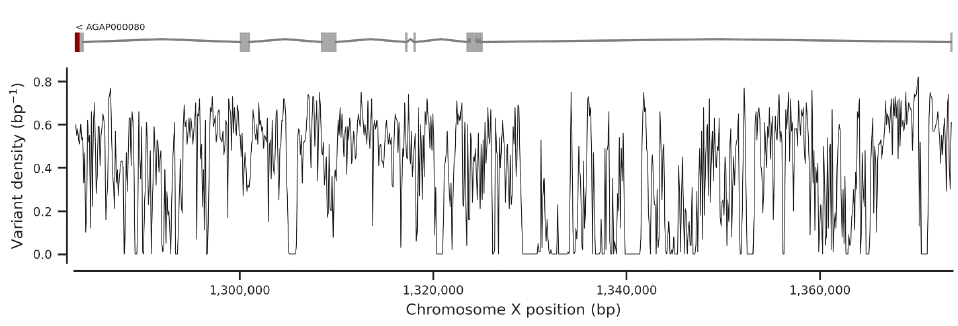
Figure A1. Variant density (bp −1 ) in the genomic region of the Fruitless gene; upper figure is the genomic region of the Fruitless gene (rectangles correspond to the exonic regions, simple lines are the intronic regions, and dark-red end is the 3 prime UTR); lower figure is the variant density plot.